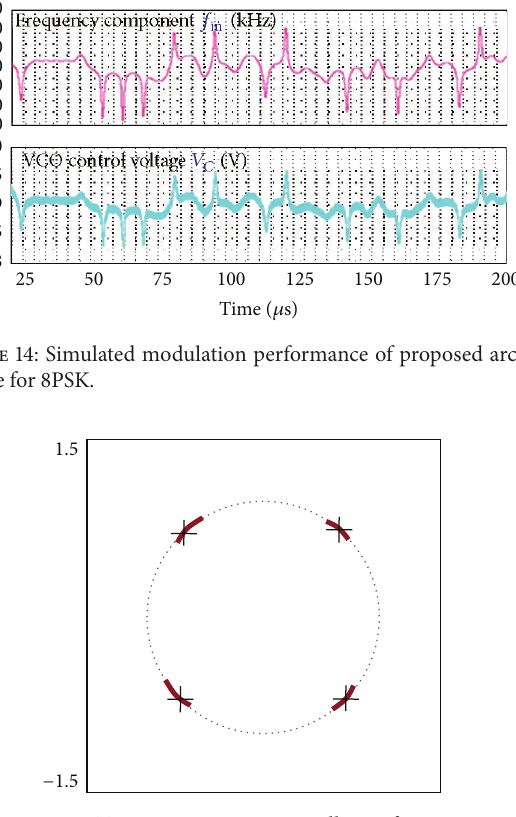
Figure 15: Transmitter output constellation for